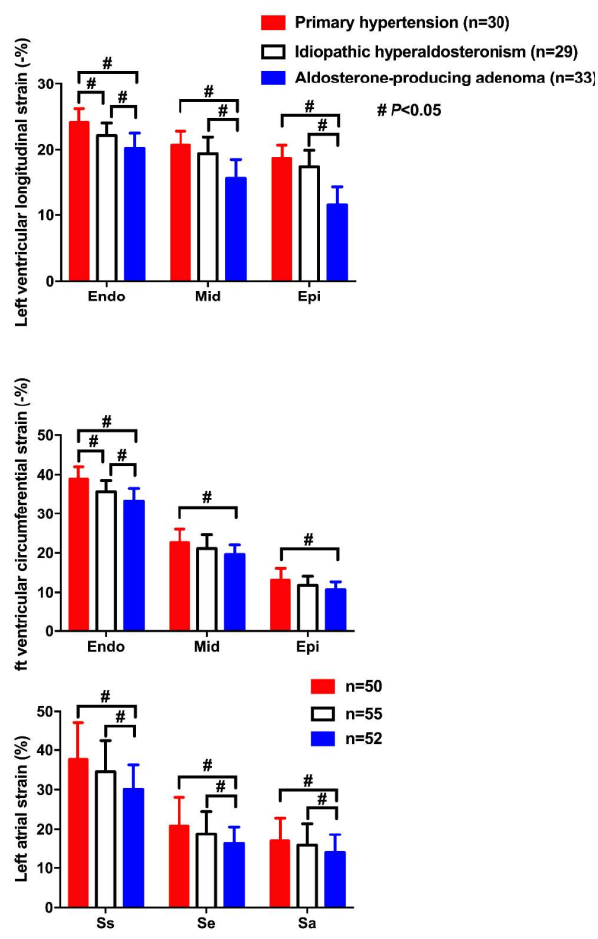
Figure 1. Left ventricular longitudinal ( upper ) and circumferential ( middle ) layer strain analyses and left atrial strain ( lower ) analyses in patients with primary hypertension (red bars), idiopathic hyperaldosteronism (white bars) and aldosterone producing adenoma (blue bars). Symbols represent mean and vertical lines denote standard deviation. Ss—left atrial strain during reservoir period; Se—left atrial strain during conduit period; Sa—left atrial strain during contractile period. The number of patients among the three groups are given. Reproduced with permission from Wang D, et al.